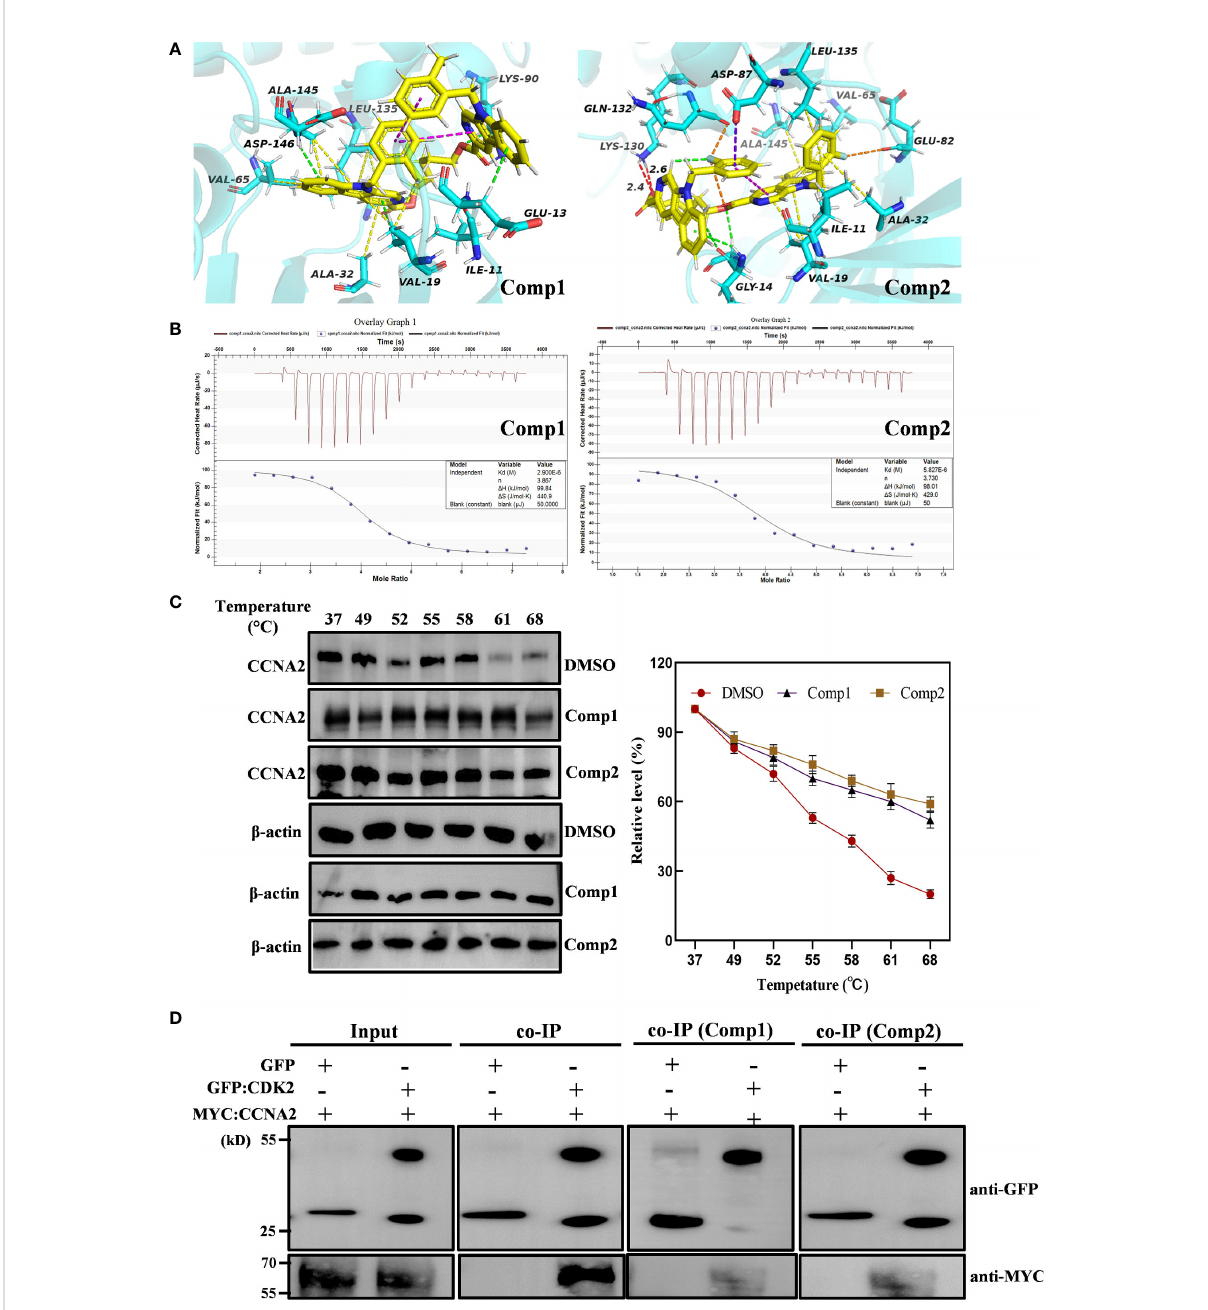
FIGURE 7 b - Carboline-3-carboxylic acid dimers directly inserted into CCNA2. (PDB ID: 1E9H). (A) CCNA2 backbone-ligand Comp1 interaction (color code for ligand: Yellow-C: White-H; Red-O; Blue-N); CCNA2 backbone-ligand Comp2 interactions (color code for ligand: Yellow-C; White-H; Red-O; Blue-N; cyans-F). (B) Isothermal titration calorimetry (ITC) enthalpograms of Comp1 and Comp2 binding to CCNA2. Titration data are presented as colored circles and fi t as black solid lines. The molar ratio (N), equilibrium dissociation constant (KD), and enthalpy change ( Δ H) are shown in the inset. (C) The cell lysates were heated at the indicated temperature and protein was measured by Western blot. (D) Co-immunoprecipitation (co-IP) assay shows that Comp1 and Comp2 block the interaction of CCNA2 with CDK2. The interaction af fi nity between CCNA2 and CDK2 is signi fi cantly decreased by the presence of b -Carboline-3-carboxylic acid